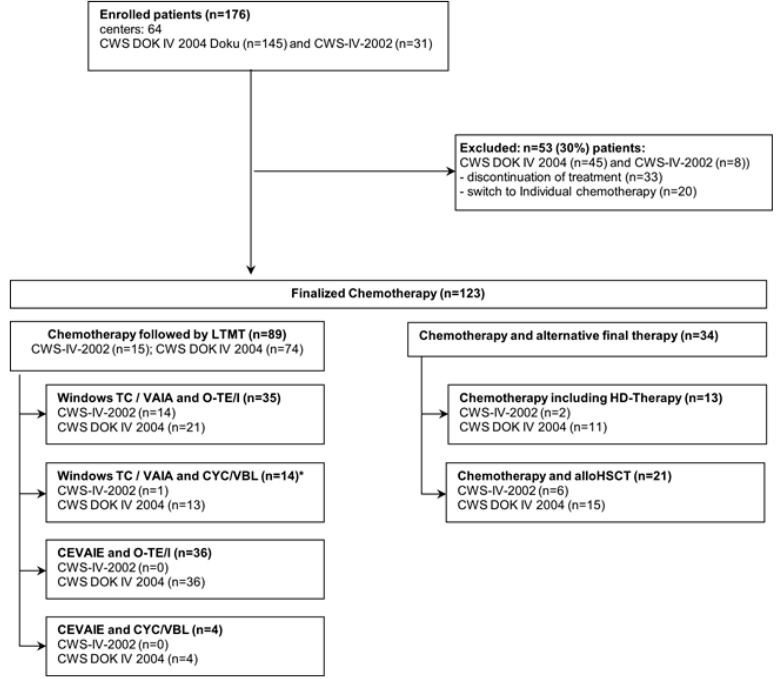
Figure 1. The diagram illustrates the distribution of 176 patients on inclusion and exclusion criteria, and the different chemotherapy treatment regimens of all patients. * One patient with other therapy but including also WTC/VAIA + CYC/VBL was allocated here.